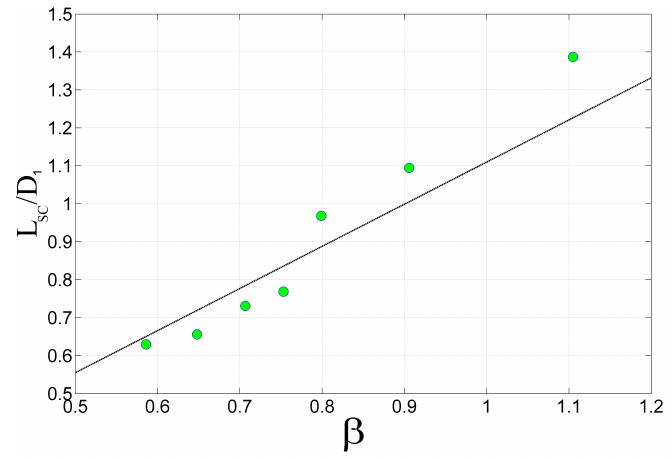
Figure 20. Evolution of the mean shock-cell length L sc with the off-design factor β . The black solid line denotes the semiempirical correlation proposed by Harper Bourne and Fisher